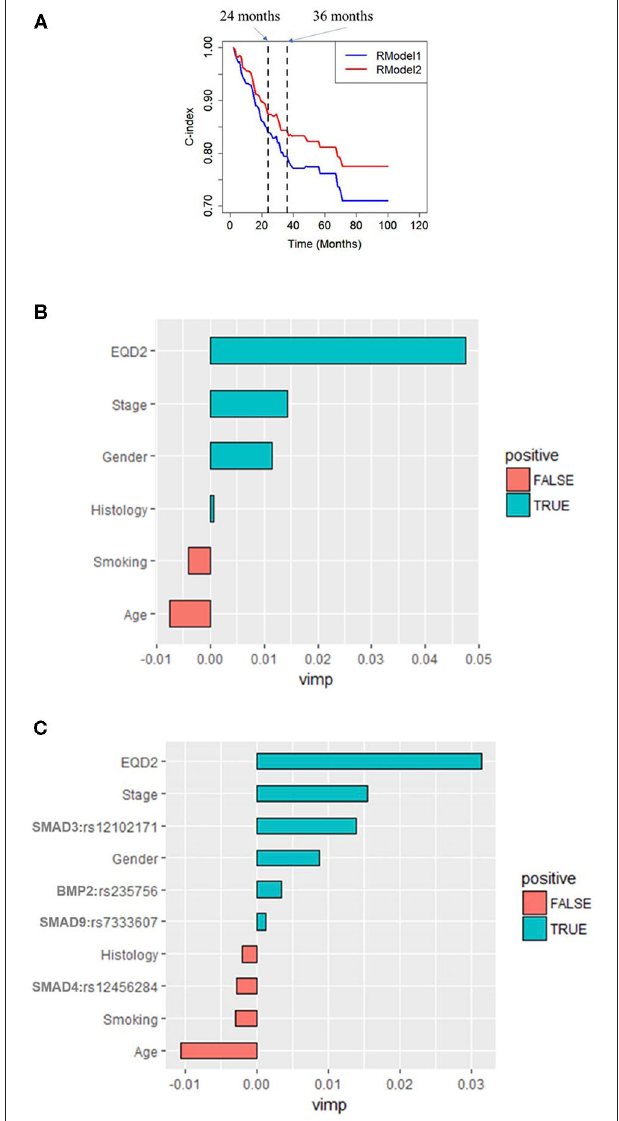
FIGURE 3 | (A) Time-dependent C-index of RModel1 and RModel2 . RModel2 increased the C-index from 0.73 to 0.78 compared with RModel1 at 24 months. Importance of predictors (VIMP) in the random forest for (B) RModel1 and (C) RModel2 . RModel1 : a model of combining only clinical predictors. RModel2 : a model of combining significant clinical and genetic